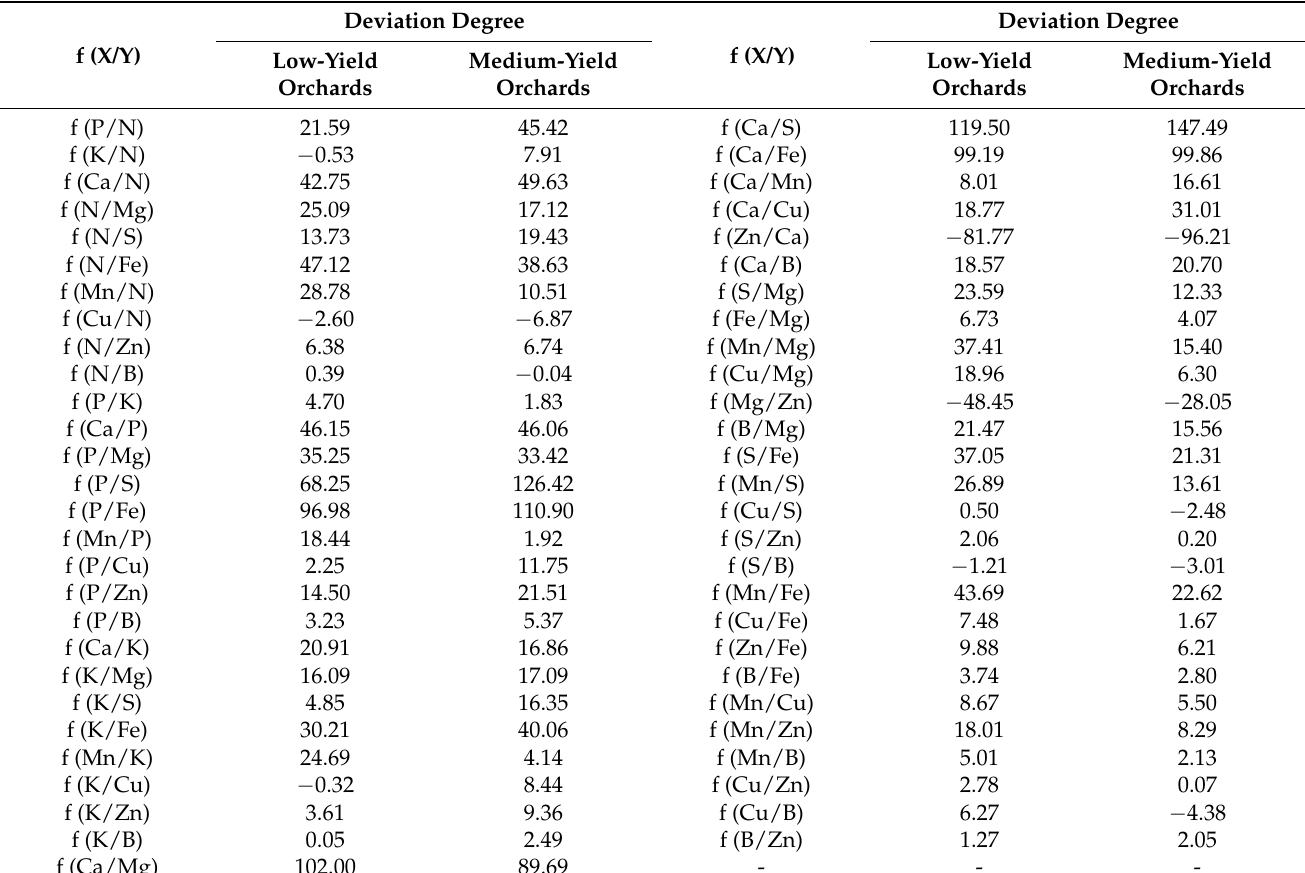
Table 3. The statistics of the Diagnosis and Recommendation Integrated System of the extent of deviation in the high-yielding orchards of Tainong